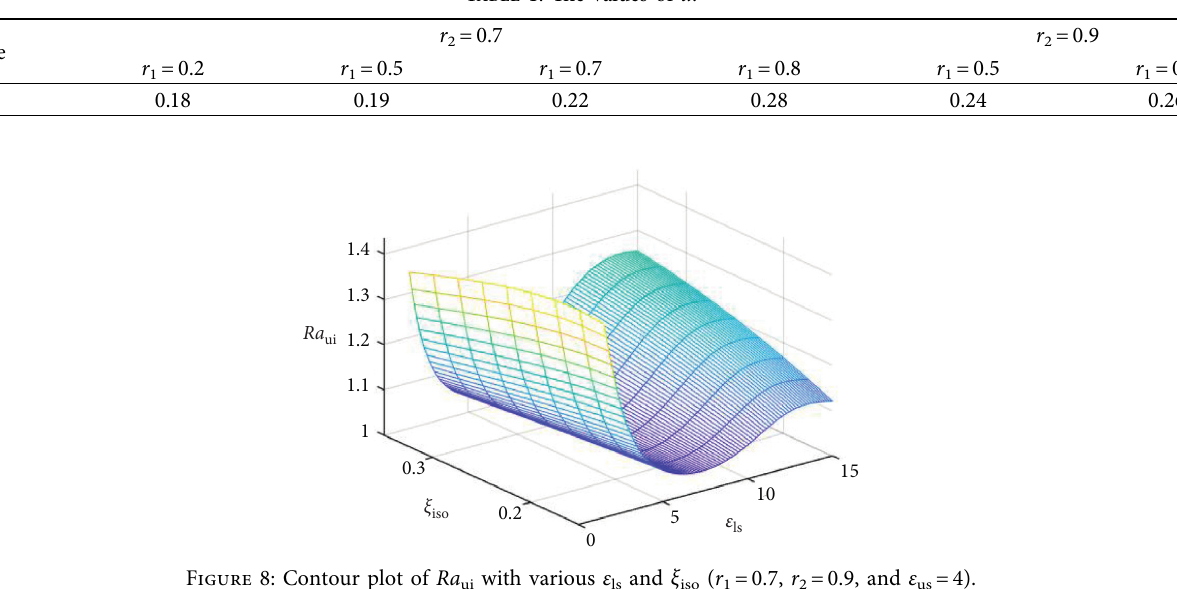
ui with various ε ls and ξ iso ( r 1